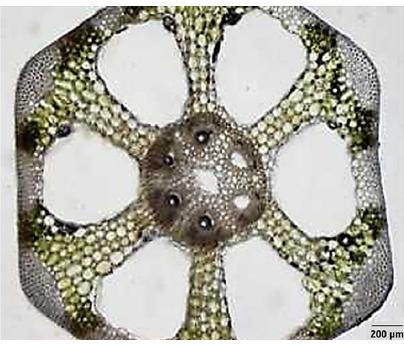
Figure 6. The cross-section of marsh horsetail ( Equisetum palustre L.) stem. Photo Matej